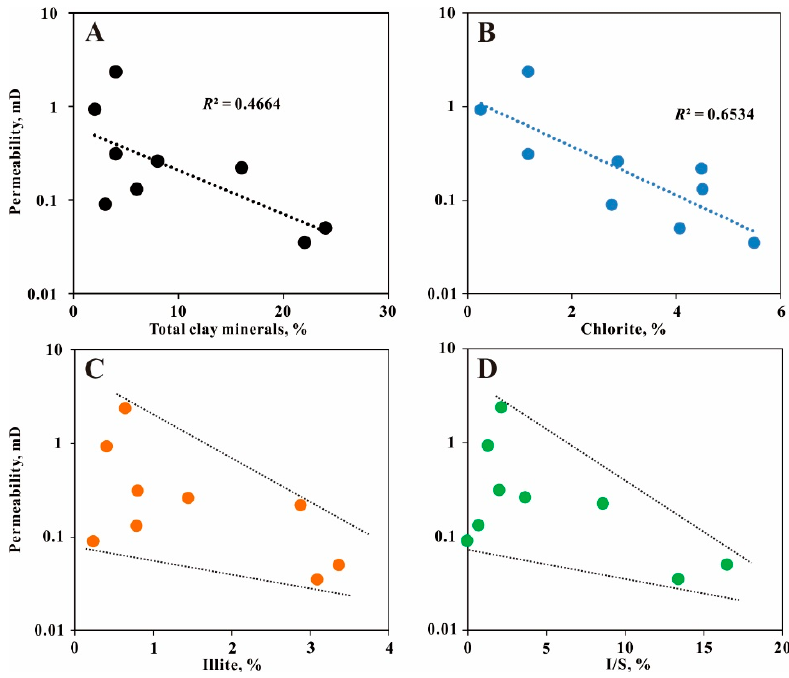
Figure 18. Relationships between contents of total clay minerals ( A ), chlorite ( B ), illite ( C ), I / S ( D ), and permeability.